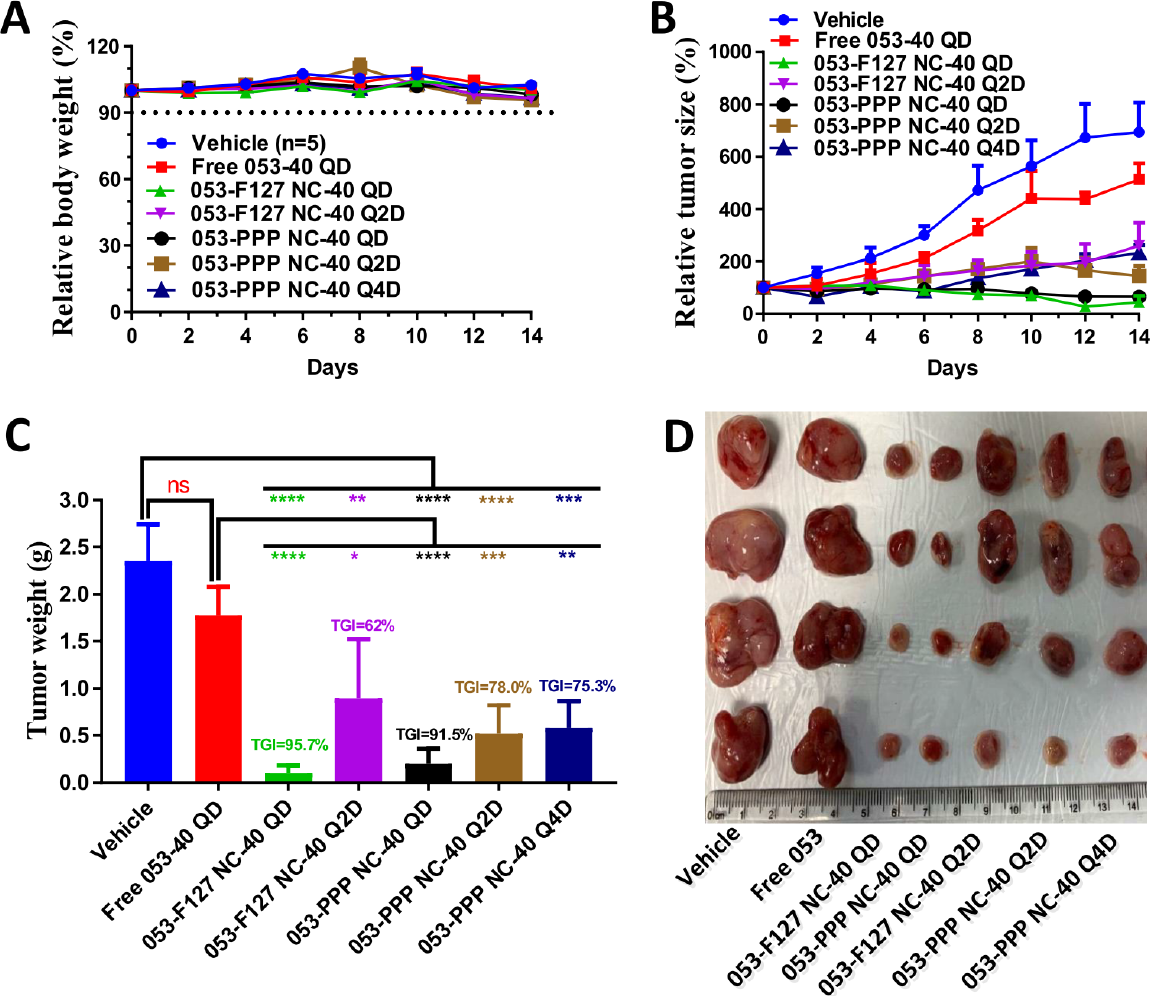
Figure 7. In vivo antitumor efficacy of free 053 (PO), 053-F127 NC (IV) and 053-PPP NC micelles (IV) using K562 xenograft mouse model. Seven groups (n = 5): (1) vehicle (PBS as control, IV injection daily), (2) free 053 40 mg/kg QD (free 053 powder dispersed in 0.5% methylcellulose/0.4% tween 80 in ddH2O, once a day), (3) 053-F127 NC 40 mg/kg QD (once a day, IV), (4) 053-F127 NC 40 mg/kg Q2D (once every other day, IV), (5) 053-PPP NC micelle 40 mg/kg QD (once a day, IV), (6) 053-PPP NC micelle 40 mg/kg Q2D (once every other day, IV), (7) 053-PPP NC micelle 40 mg/kg Q4D (once every 4 days, IV). Relative changes in body weight for each mouse group following the treatment were monitored (initial body weight was set as 100%) ( A ). Relative change in tumor size of xenograft mice during the treatment (initial tumor size was set as 100%) ( B ). Comparison of the final tumor weight for each group at the end of the treatment (TGI, tumor growth inhibition) ( C ). Representative pictures of tumors for each group at the end of the treatment ( D ). (ns: statistically non-significant; *: statistically significant at p < 0.05; **: highly significant at p < 0.01; ***: extremely significant at p < 0.001; ****: extremely significant at p < 0.0001).